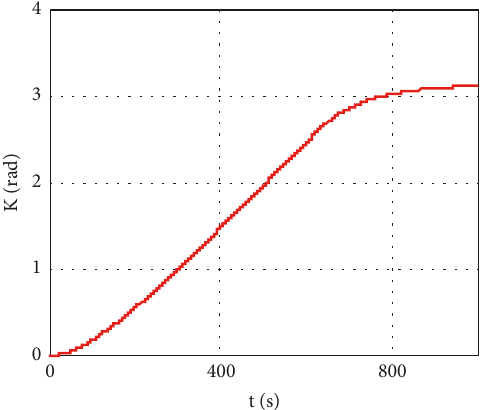
Figure 13: Time dependence of the heading angle during rotation towards the return course for values 𝑧 ∗ 3 = 0.005𝑟𝑎𝑑 ⋅ 𝑠 −1 , 𝑧 ∗ 6 = 3.14 𝑟𝑎𝑑 ; 𝑇 = 2 𝑠 . 𝑢